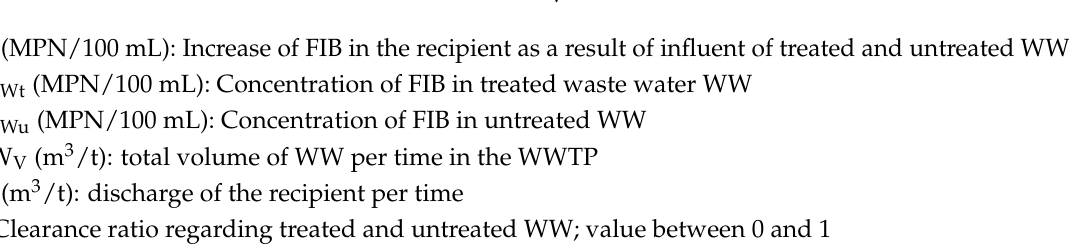
Figure 2. Concentrations of FC, EC and IE in the raw sewage sludge (SSr) and stabilized sludge (SSs), (N = 54).